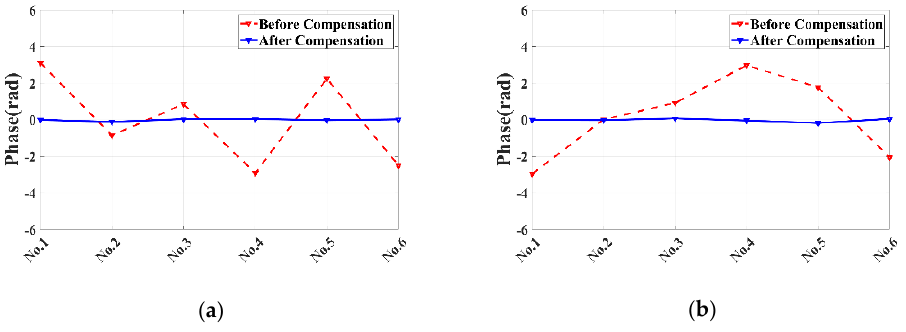
Figure 12. Compensation results of CRs error phases: ( a ) CR 1 ; ( b ) CR 2 . Error! Reference source not found. shows the statistics of the maximum values and standard deviation σ of the residual phases for both CRs before and after the error com- pensation. σ is about 0.1 rad after compensation. For the Ku-band GB-MIMO radar, the corresponding deformation is 0.14 mm, which meets the requirements of sub-millimeter measuremen. Table 4. Statistical results of residual phases for both CRs.